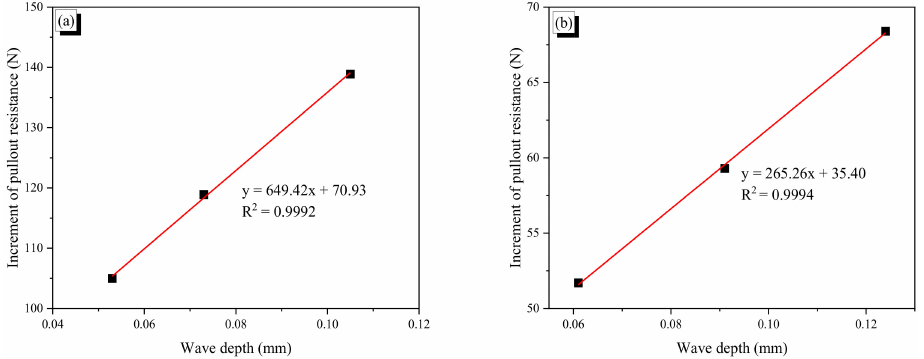
Figure 16. Increment of pullout resistance as a function of wave depth: ( a ) CR1.0-N fibers; ( b ) CR0.7-N